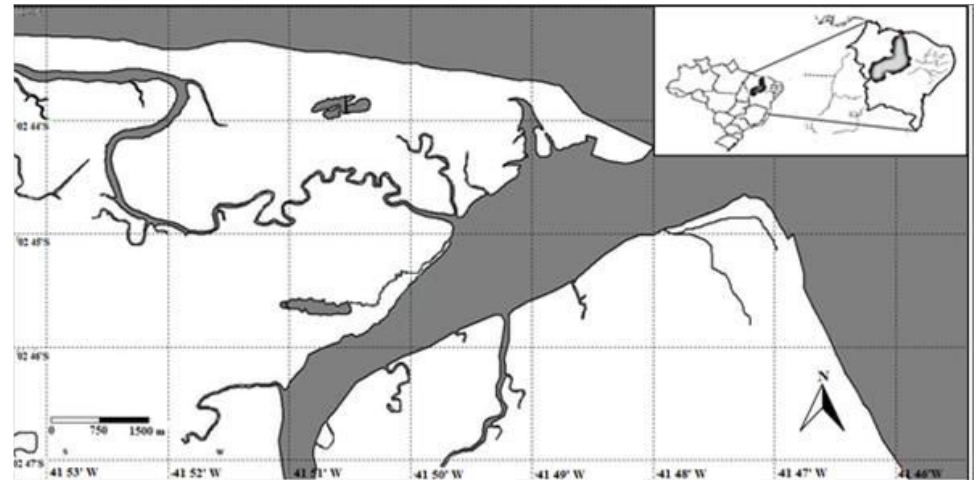
Figure 1. Study area highlighting the location of the Parnaiba River Delta